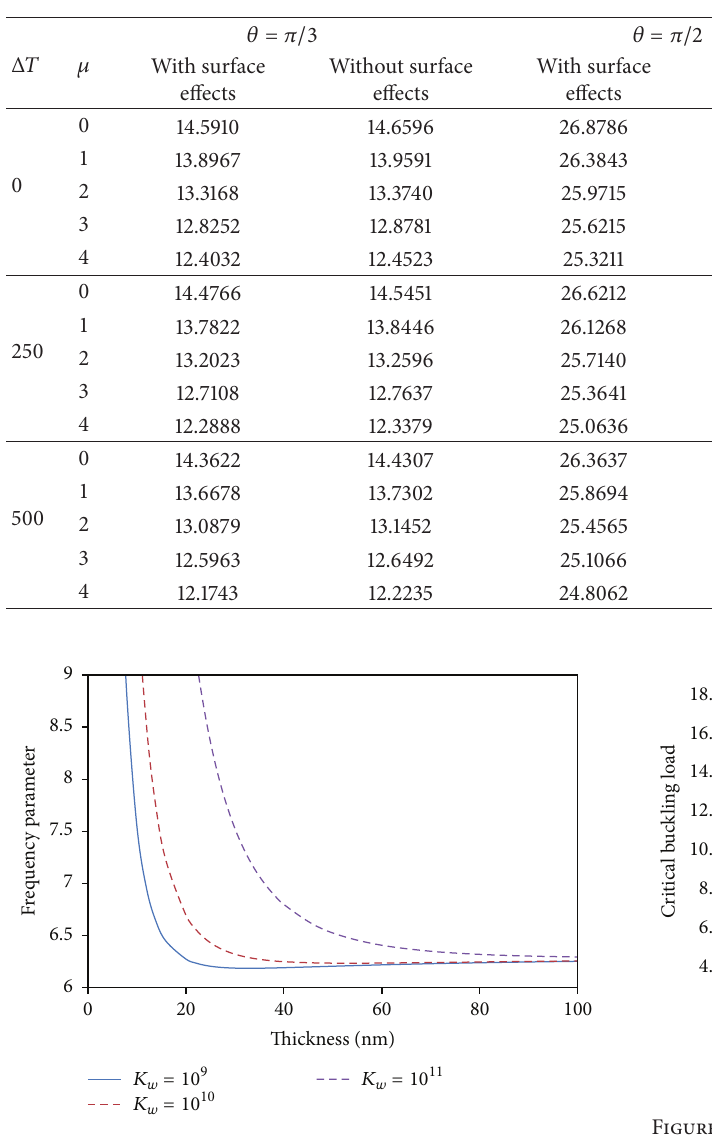
Figure 8: Dimensionless natural frequency with respect to thick- ness ℎ for various Winkler elastic foundations (𝐾 𝑝 = 10 −6 , 𝑅 = 30 nm , Δ𝑇 = 100, 𝜇 = 1, 𝑏 = 50 nm , 𝜃 = 𝜋/2) .